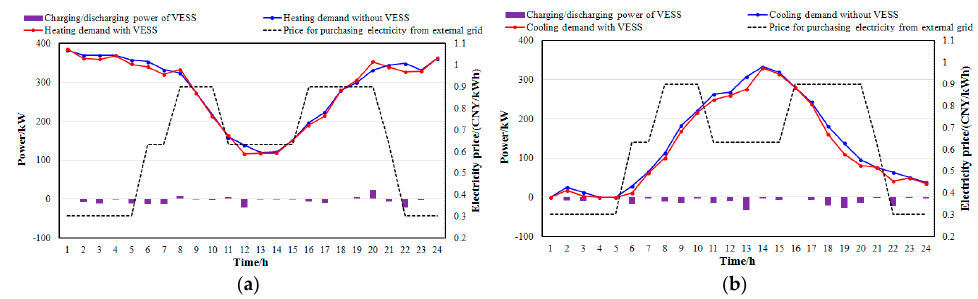
Figure 14. VESS charging/discharging power in minimized OC scheduling scheme for RR-microgrid with CHCS. ( a ) A typical day in winter; and ( b ) a typical day in summer.